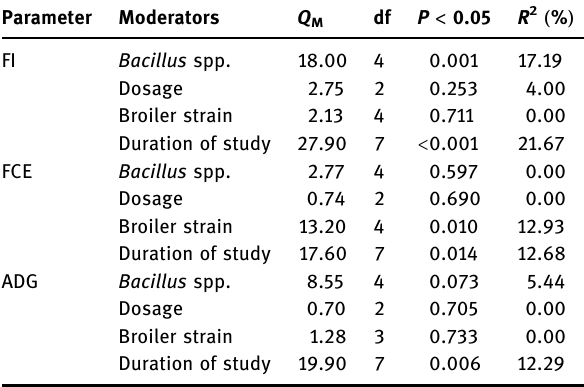
Table 5: Meta - regression of the moderator variables Parameter